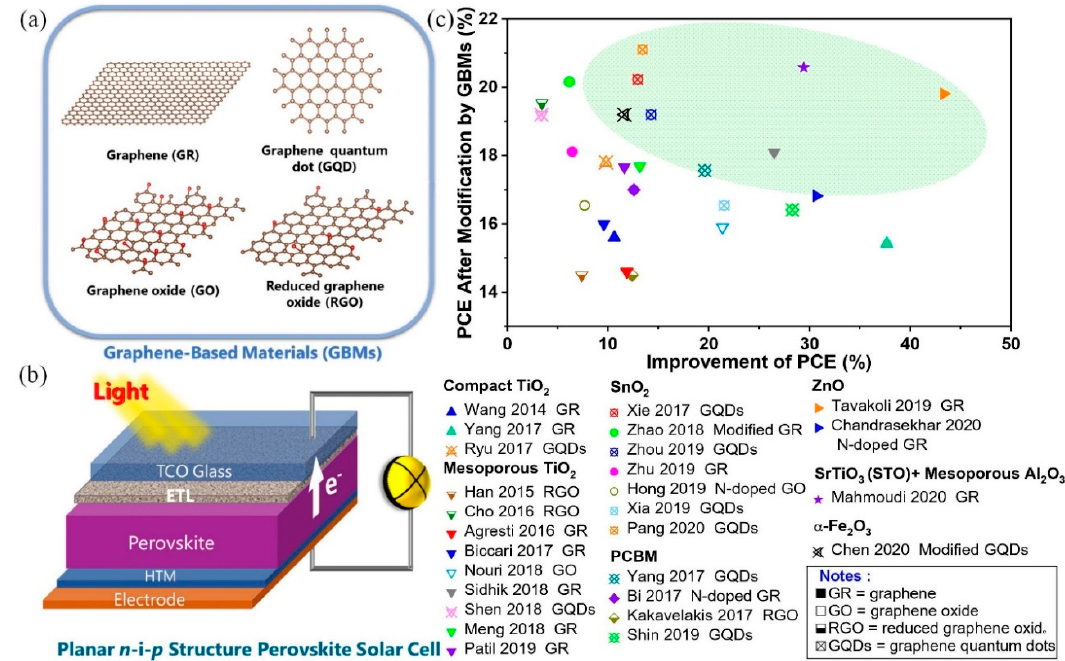
Figure 1. ( a ) Schematic of structures of graphene and its derivatives, ( b ) schematic cross section of planar n-i-p structure PSC, ( c ) comprehensive summary of power conversion e ffi ciency (PCE) data for halide perovskite solar cells (PSCs) with electron transport layers (ETLs) comprised of graphene-based materials (GBMs) (power conversion e ffi ciency (PCE) > 14%) [17–20,23,25–27,39,43,55,56,60,63–74] (TCO = transparent conducting oxide, HTM = hole transport material, green area = most e ffi cient configurations for GBM-modified